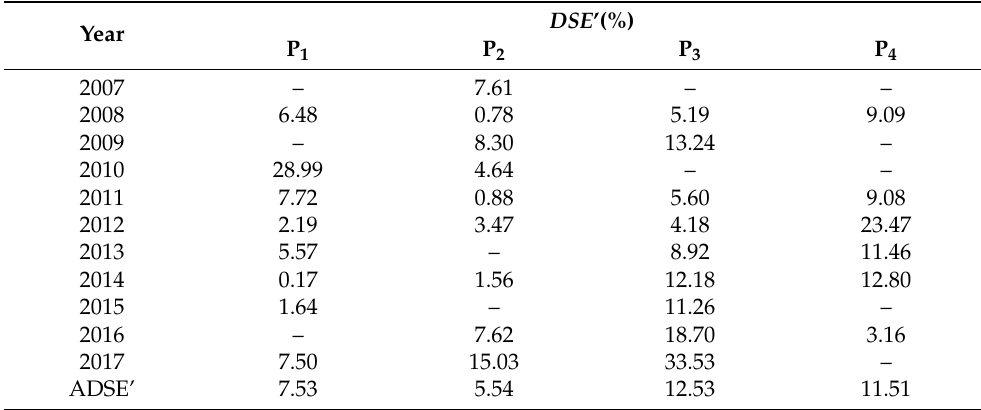
Table 1. Variation of DSE (cid:48) in four stages from 2007 to 2017.